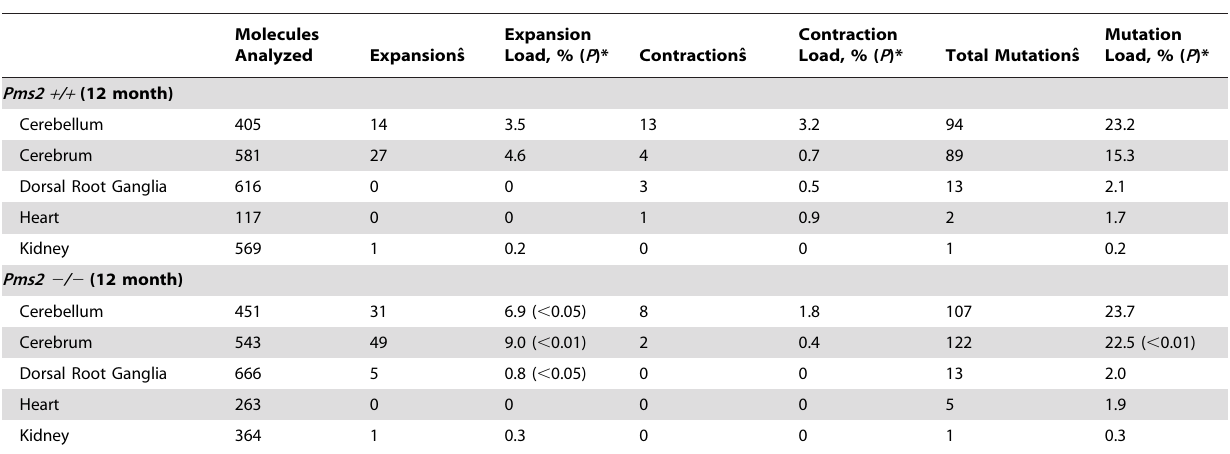
* P values indicate statistical significance between + / + and 2 / 2 . P values are not indicated when not significant. ˆ Because multiple progenitor alleles were present, changes between progenitors could not be definitively identified as contractions or expansions. Contractions and expansions were conservatively defined as molecules that were at least 5% shorter than the smallest progenitor or 5% longer than the largest progenitor, respectively. Contractions, expansions, and changes between progenitors were included in ‘‘Total